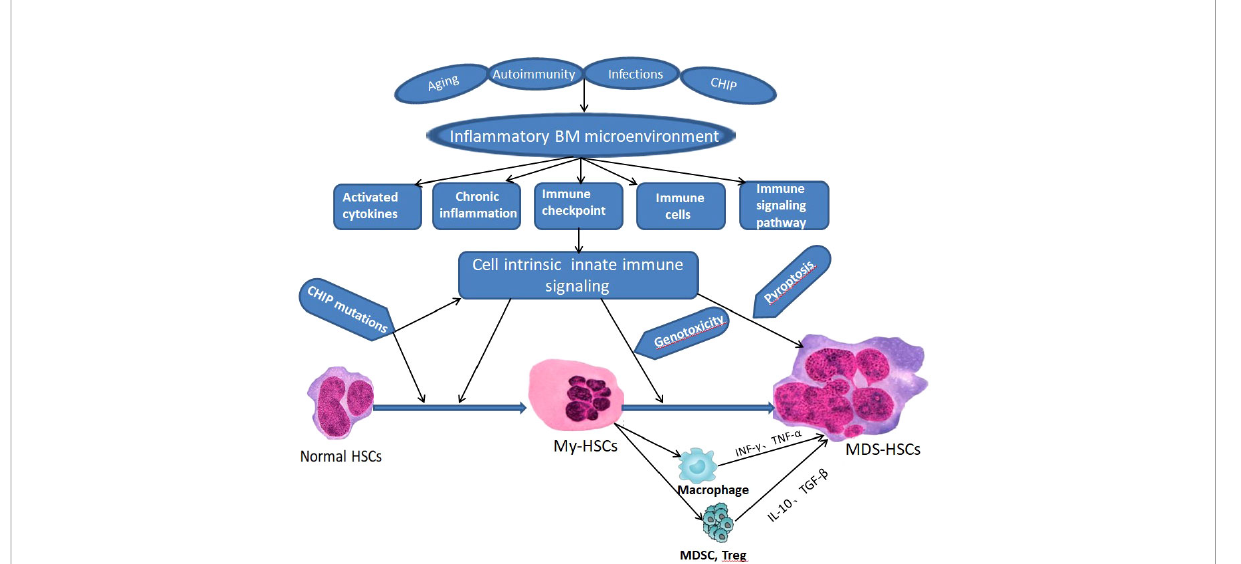
FIGURE 2 Schematic of innate immune signaling dysregulation in the pathogenesis of MDS. CHIP - clonal hematopoiesis of indeterminate potential, BM, bone marrow, HSCs - hematopoietic stem cells; My-HSCs, myeloid biased